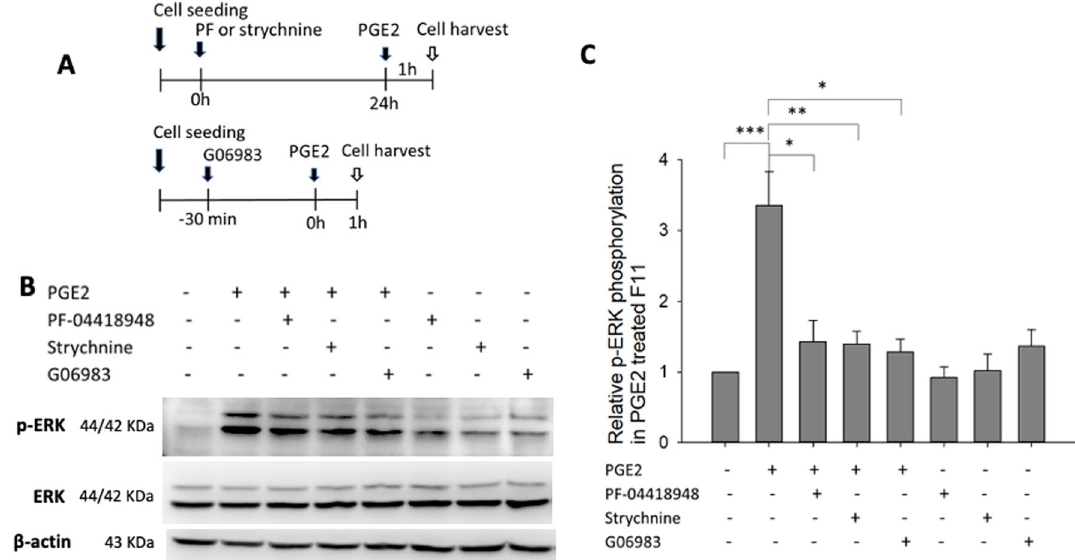
Fig. 2 Effects of prostaglandin EP2‑receptor antagonist (PF‑04418948), glycine‑receptor antagonist (strychnine), and PKC inhibitor (G06983) on PGE2‑induced ERK phosphorylation. A Time schedule in which F11 cells were seeded into a 6‑well plate for 24 h; PF‑04418948 (10 μM) or strychnine (10 μM) was applied and incubated for 24 h before PGE2 treatment. G06983 (3 μM) was applied 30 min before PGE2 treatment. One hour after PGE2 (100 μM) application, cells were harvested for protein extraction. B Western blotting of ERK phosphorylation and C quantification of ERK phosphorylation in F11 cells. F11 cells without inhibitors or PGE2 treatment were used as a control. The data are presented on the basis of from three to five independent experiments. * p < 0.05, ** p < 0.01, and *** p < 0.001, one‑way